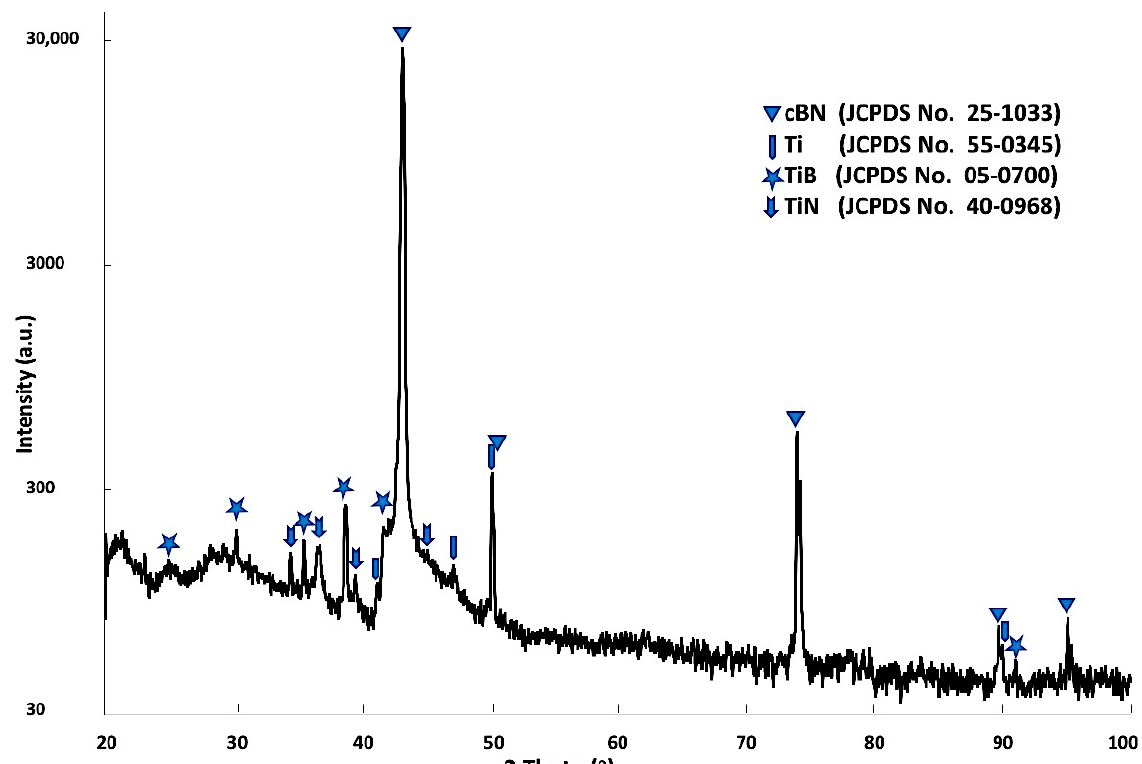
Figure 6. X ‐ ray diffraction patterns of Ti ‐ metallized cBN abrasive particles by molten salt reaction. Figure 6. X-ray diffraction patterns of Ti-metallized cBN abrasive particles by molten salt reaction. In the Ti metallization process of the cBN particles by molten salt reactions process at a high reaction temperature of 900 ◦ C, K 2 TiF 6 dissolved into the reaction mixture of NaCl/KCl molten salts and the Ti 4+ cation was produced. K 2 TiF 6 was added to the molten salt mixture to enhance the Ti atoms and reacted with Ti 4+ cations from the decomposed K 2 TiF 6 and produce Ti 4+ . Then, the interaction of K 2 TiF 6 with the NaCl/KCl molten salt mixture helped in the formation of titanium cations. The coating process began with the deposition of Ti 4+ from the molten salt onto the surface of the cBN abrasive